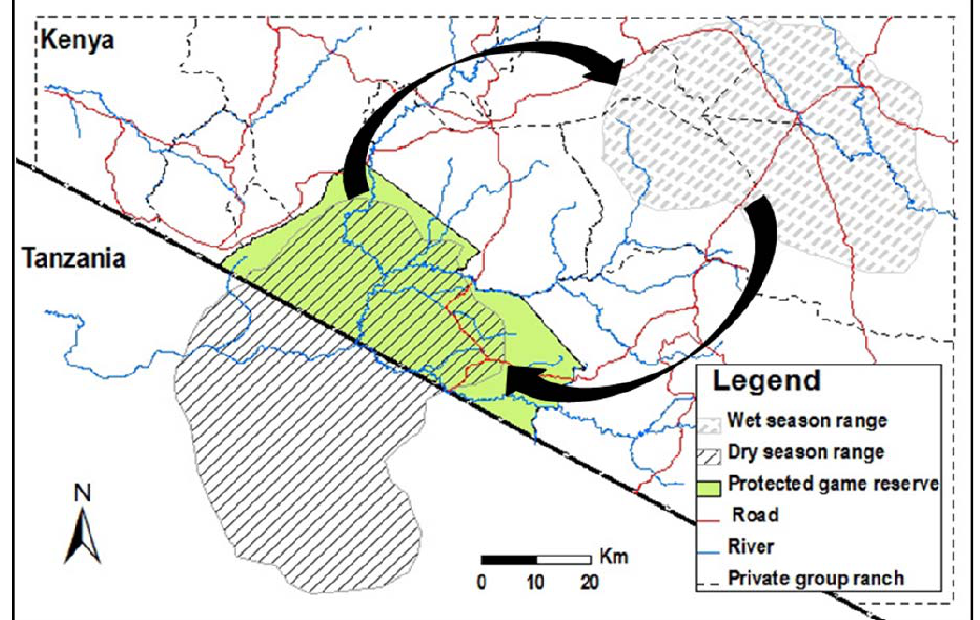
Figure 2. Wildlife movements in the study area (modified from Maddock,